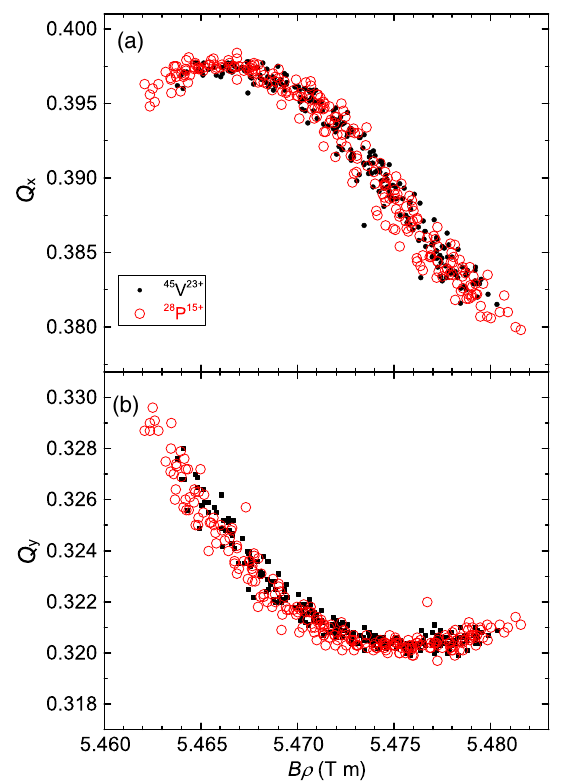
FIG. 12. Scattering plot offitted Q ¼ Q 0 þ 2 Q 1 · N valuesat the middlerevolutionnumber, Q x (a)and Q y (b), for 45 V 23 þ (blackdot) and 28 P 15 þ (red circle) ions. The magnetic rigidities, B ρ , of the ions are calculated according to the known masses [44] and the measured velocities. Only the ions with a condition of A TOF 2 > 15 ps in Eq.(7) are used corresponding to 68% of thewhole